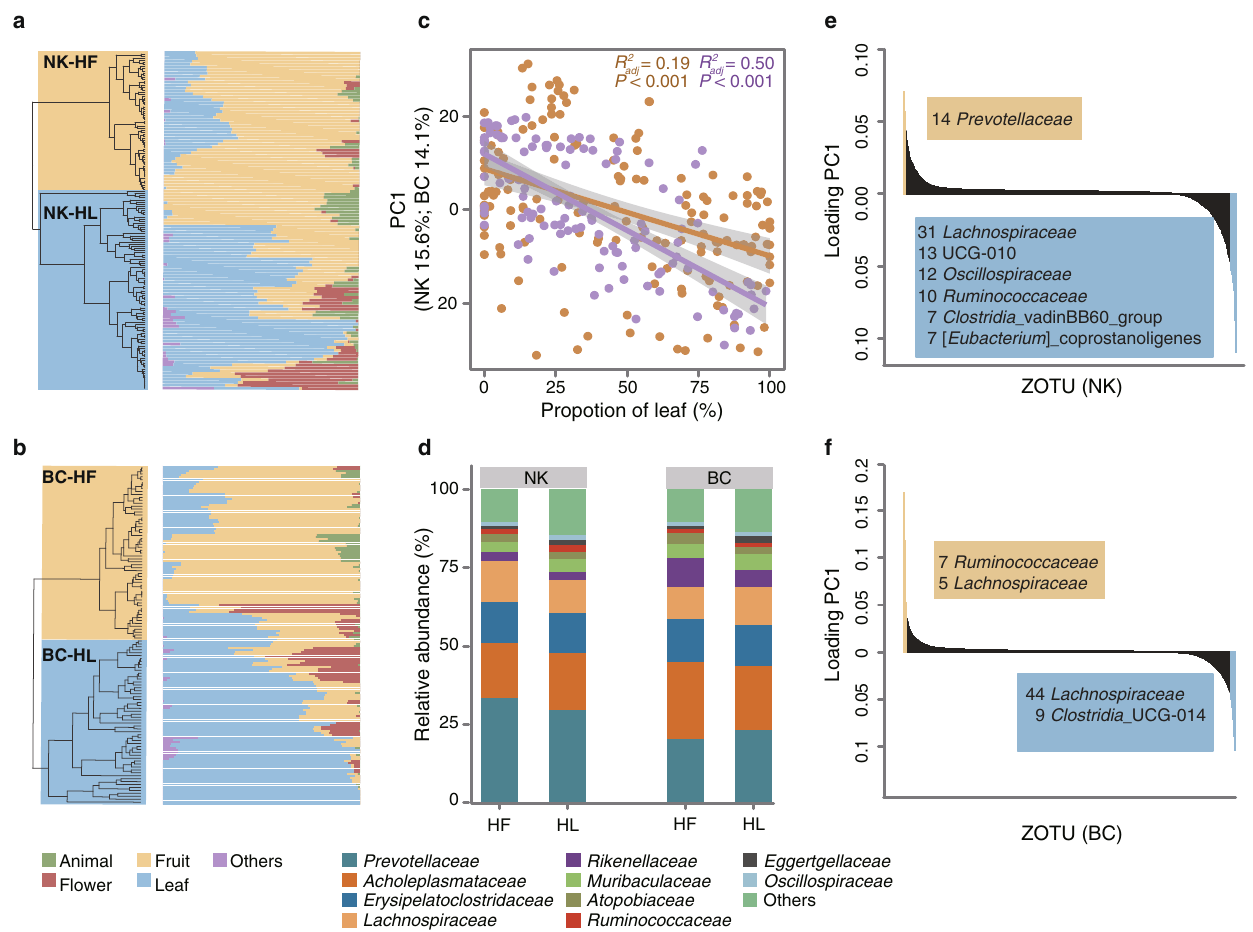
Fig. 2 Covariation of diet and gut microbiota across the social groups. a and b Hierarchical clustering with the dietary composition of the social groups ( a NK; b BC). Detailed information was provided in Supplementary Table 7. c The correlation between the fi rst principal component (PC1) of between-sample dissimilarity and the proportion of leaf in the diet with colors representing different subjects (orange, NK; purple, BC). The p -values were obtained from linear regression analysis. d Gut microbial composition of NK and BC social groups in the high-fruit and high-leaf periods (the dominant families were shown). e and f Loading PC1 scores of each ZOTU within social groups ( e , NK; f , BC) with a loading score of >0.05 and <0.05